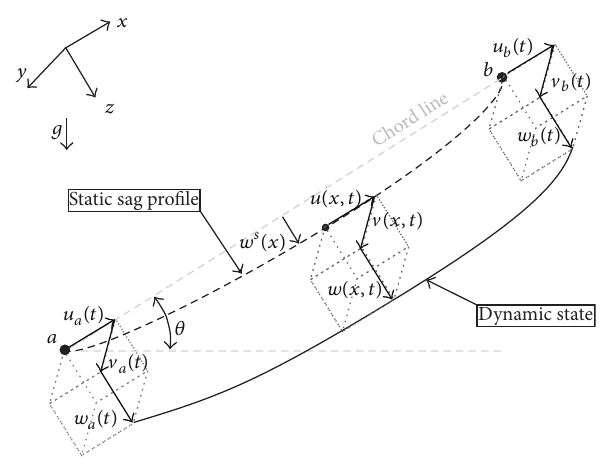
Figure 9: 3D model of an inclined cable with general support movements.